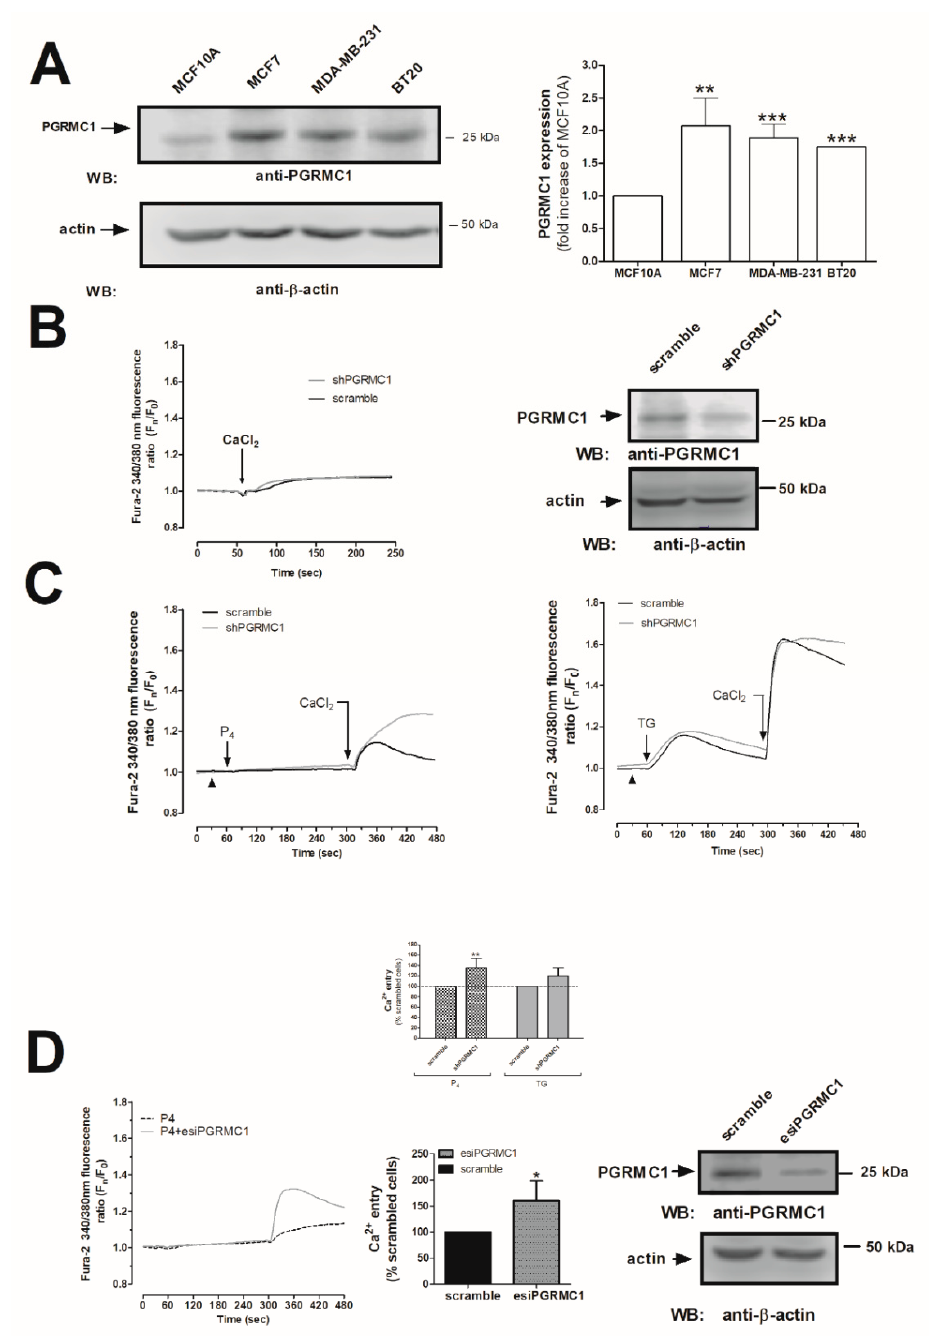
Figure 2. Progesterone receptor membrane component 1 (PGRMC1) downregulated the progesterone (P 4 )-evoked Ca 2 + entry. ( A ) Resting MCF10A, MCF7, MDA-MB-231, and BT20 cells were suspended at the same concentration, and they were subsequently lysed with NP40 bu ff er. The resulting protein samples were denaturalized by mixing with an equal volume of Laemmli’s bu ff er (5% sodium dodecyl sulphate, SDS). Subsequent Western blotting was performed by using the anti-PGRMC1 antibody, as described in Materials and Methods. The histogram represents the average of the fold increase ± S.E.M. of the amount of PGRMC1 found in MCF10A after they were previously normalized by considering the actin content in each gel lane. **, ***: represent p < 0.01 and p < 0.001 as compared to the PGRMC1 values found in MCF10A cells. ( B , C ) MDA-MB-231 cells were transfected for 48 h with 2 µ g / mL of the small hairpin siRNA against PGRMC1 (shPGRMC1) plasmid ( B ) or esiPGRMC1 ( D ), and after validation of the e ffi ciency of the silencing procedure by Western blotting, cells were incubated with 2 µ M of fura-2 / AM for 30 min at 37 ◦ C. ( B ) In order to demonstrate that the PGRMC1 silencing